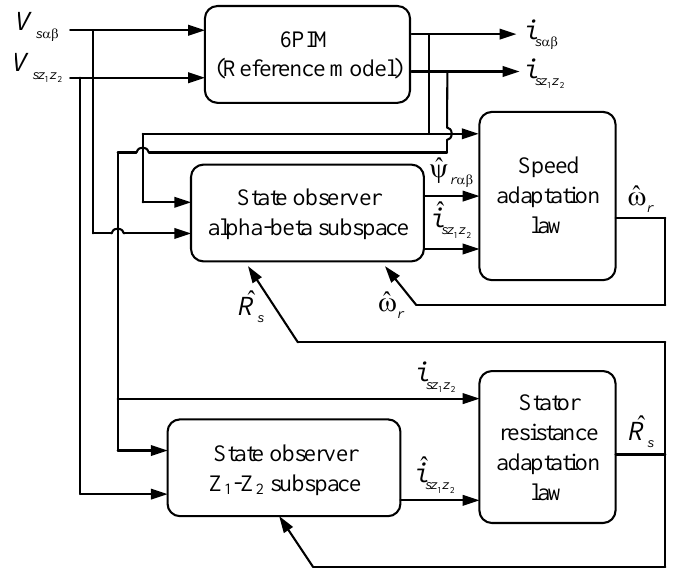
Figure 2. The block diagram of the proposed parallel estimation system of the stator resistance and the rotor speed based on an adaptive full-order